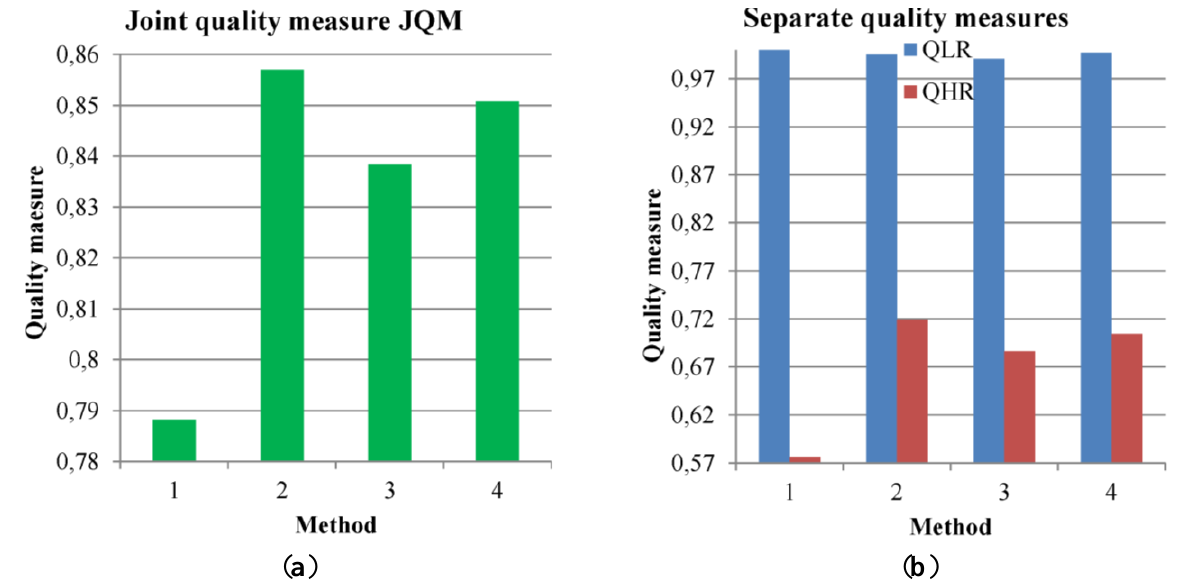
Figure 3. JQM quality assessment of interpolation methods: 1—NN, 2—ZP, 3—BIL, and 4—CUB for WV-2 data. ( a ) JQM, ( b ) QLR and